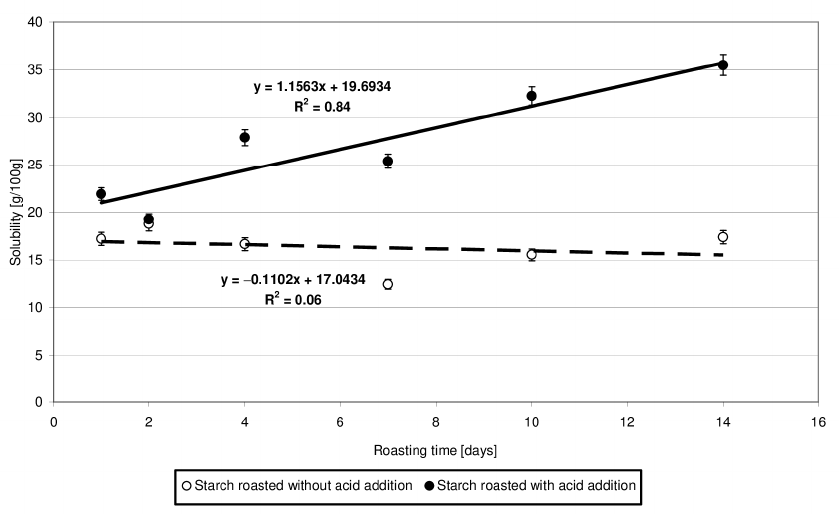
Figure 3. Dependency of solubility in water on the time of starch retention with and without citric acid.